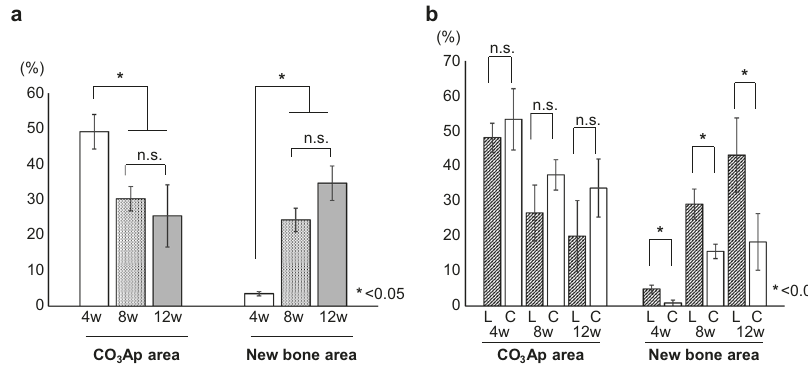
HCBs. New bone was formed along the pores of the CO 3 Ap HCB and the thickness of the new bone increased over time b Fig. 9 Comparison of new bone (%)